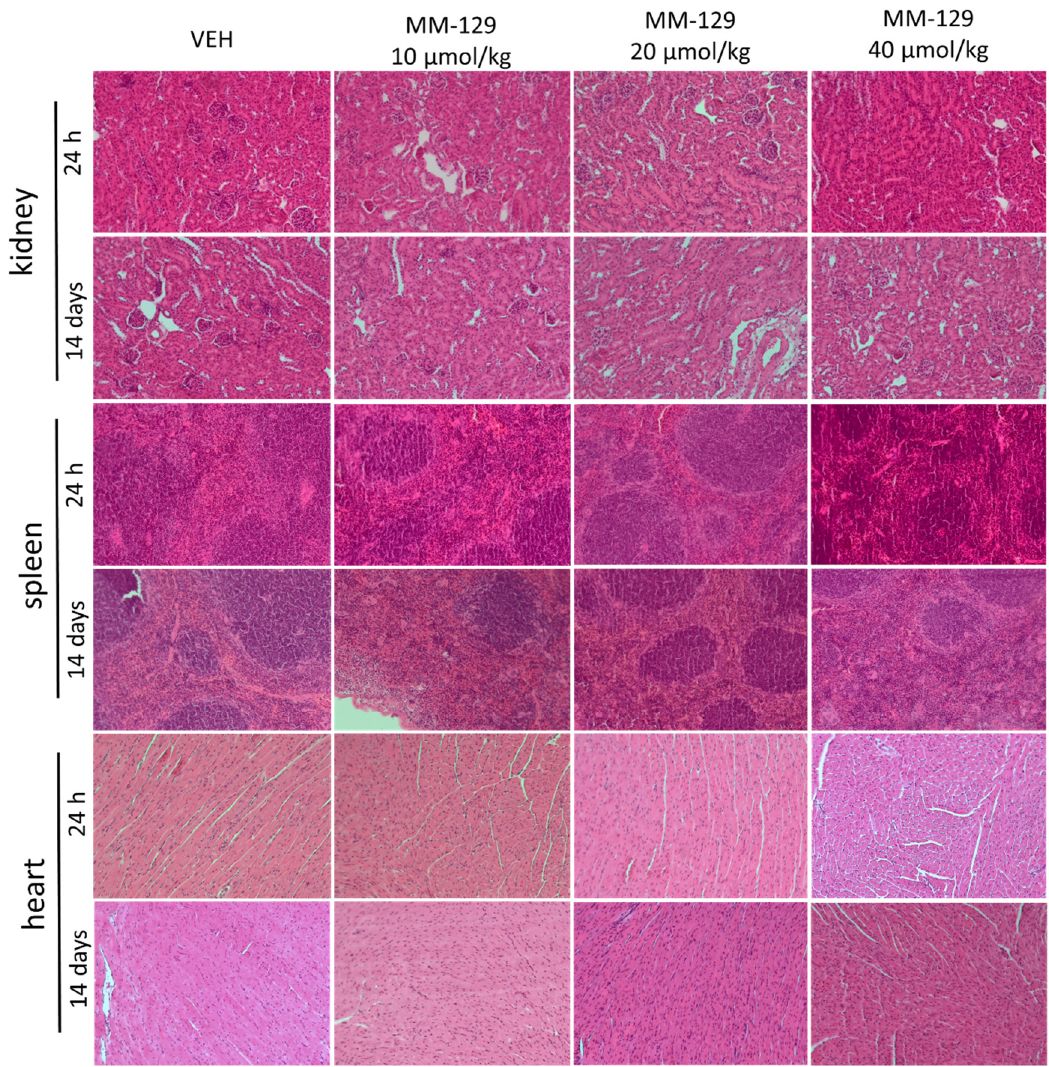
Figure 10. Representative micrographs of tissue sections of kidney, spleen and heart 24 h and 14 days after intraperitoneal administration of MM-129 at a dose of 10, 20, 40 μ mol/kg and VEH in mice. Original magnification, 10; hematoxylin and eosin staining. Abbreviations: MM-129—pyrazolo[4,3-e]tetrazolo[4,5-b][1,2,4]triazine sulfonamide; VEH—vehicle.